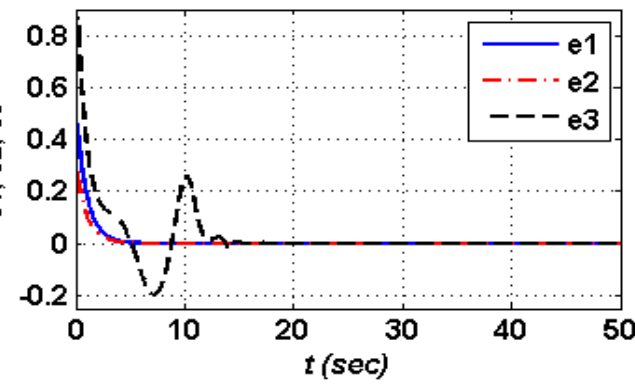
Inventions 2019 , 4 , x